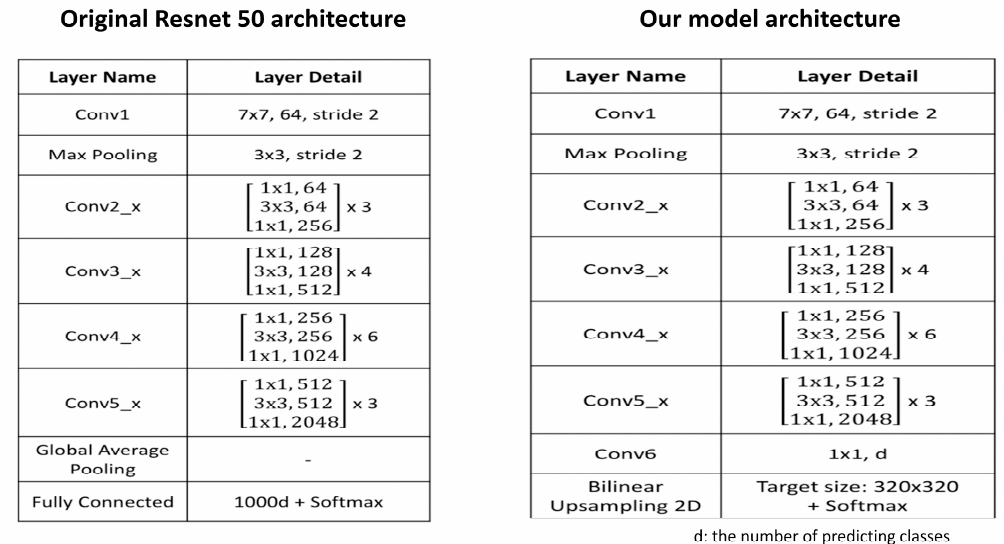
Figure 3. Comparison between original residual network (ResNet) 50 architecture and our model architecture.